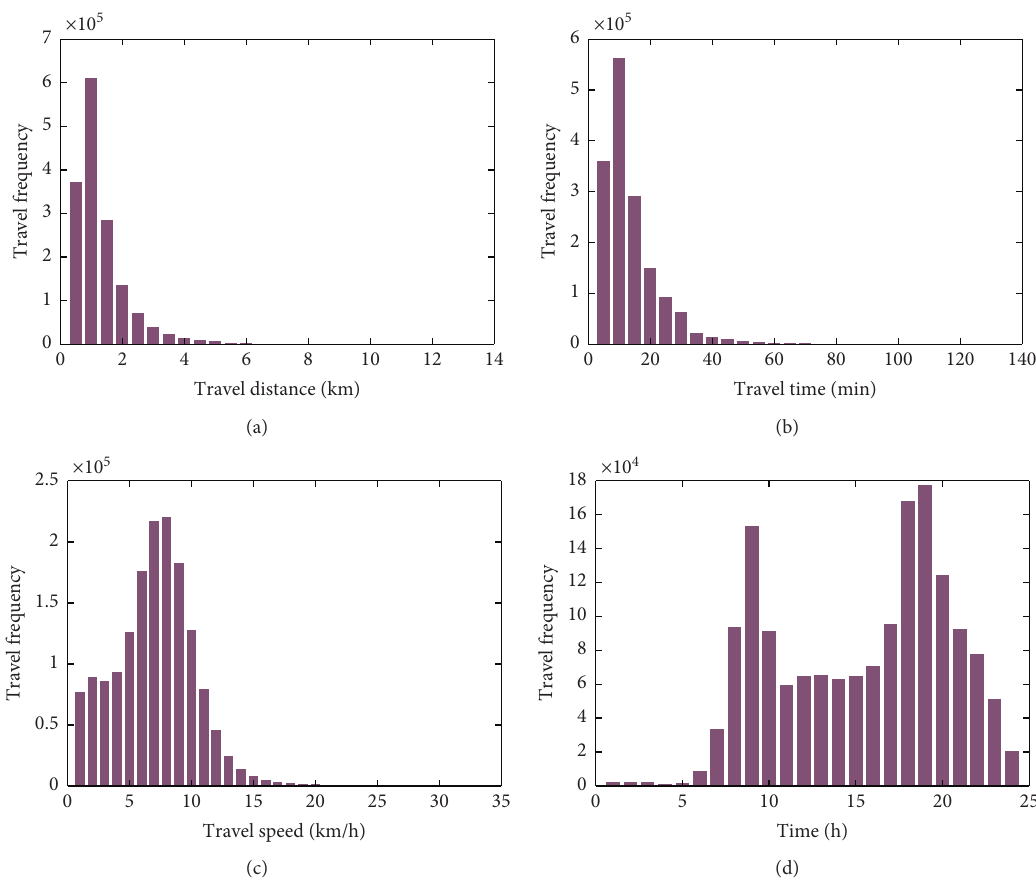
Figure 3: Distribution of dockless sharing bikes: (a) travel distance distribution, (b) travel time distribution, (c) travel speed distribution, and (d) 24-hour travel